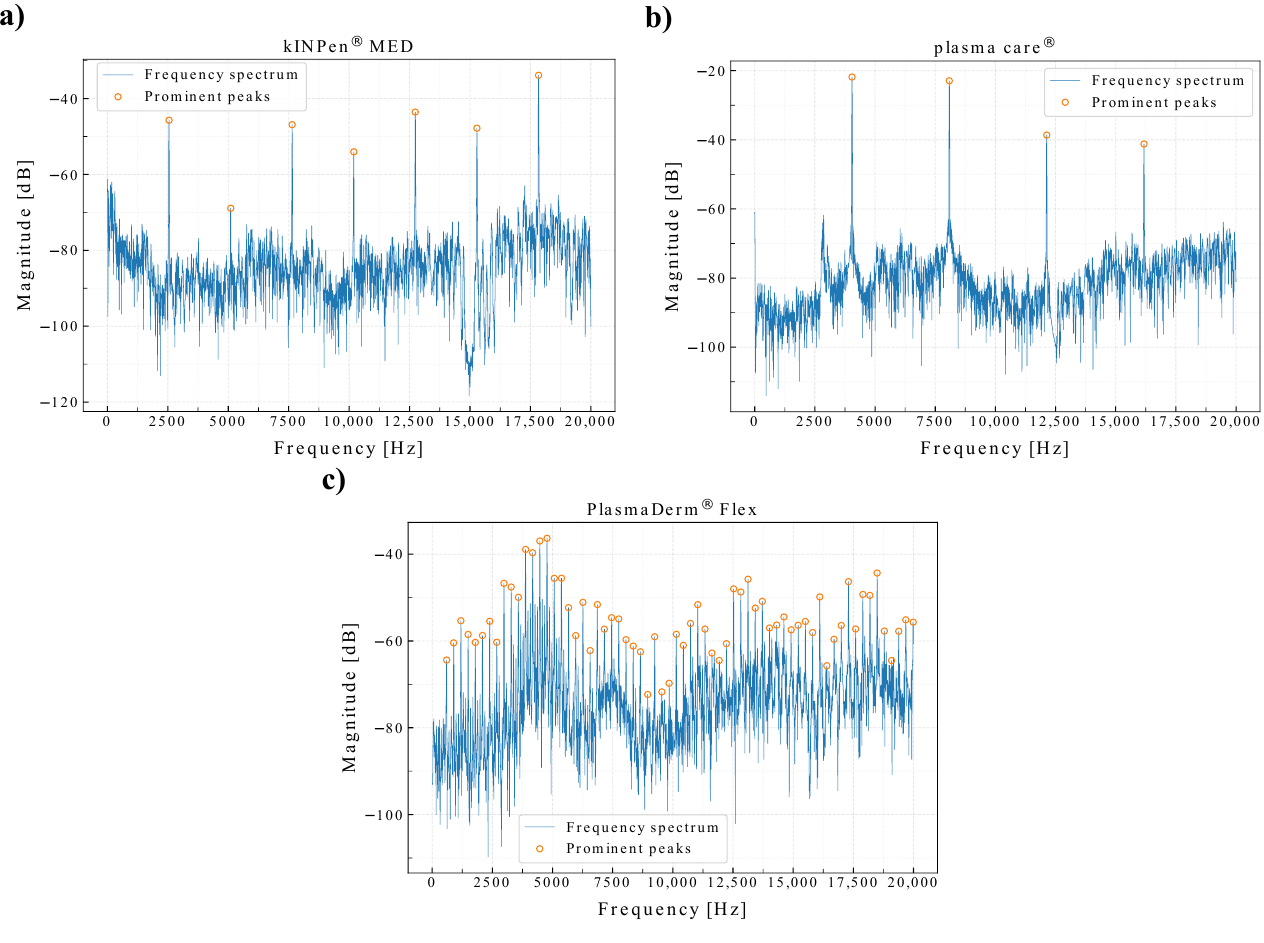
Figure 1. Sound frequency spectra (sampling rate = 44.1 kHz and sample size = 100 ms) and the prominent peaks of ( a ) kINPen ® MED, ( b ) plasma care ® , and ( c ) PlasmaDerm ®